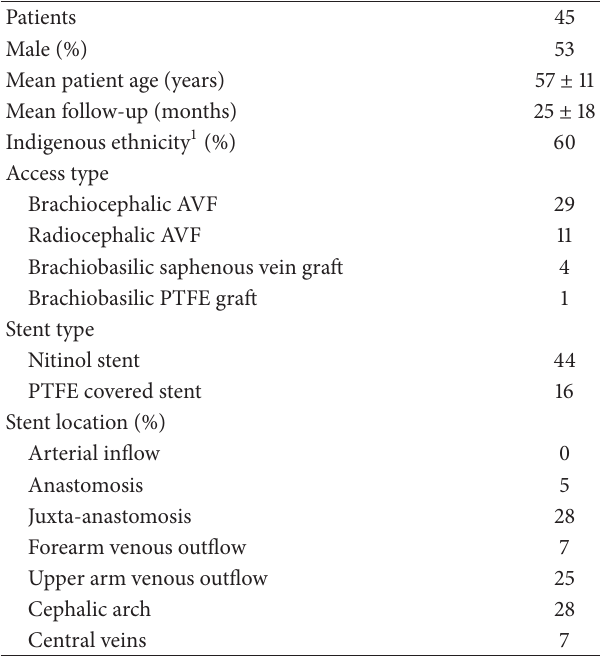
Table 1: Baseline patient characteristics and intervention details.